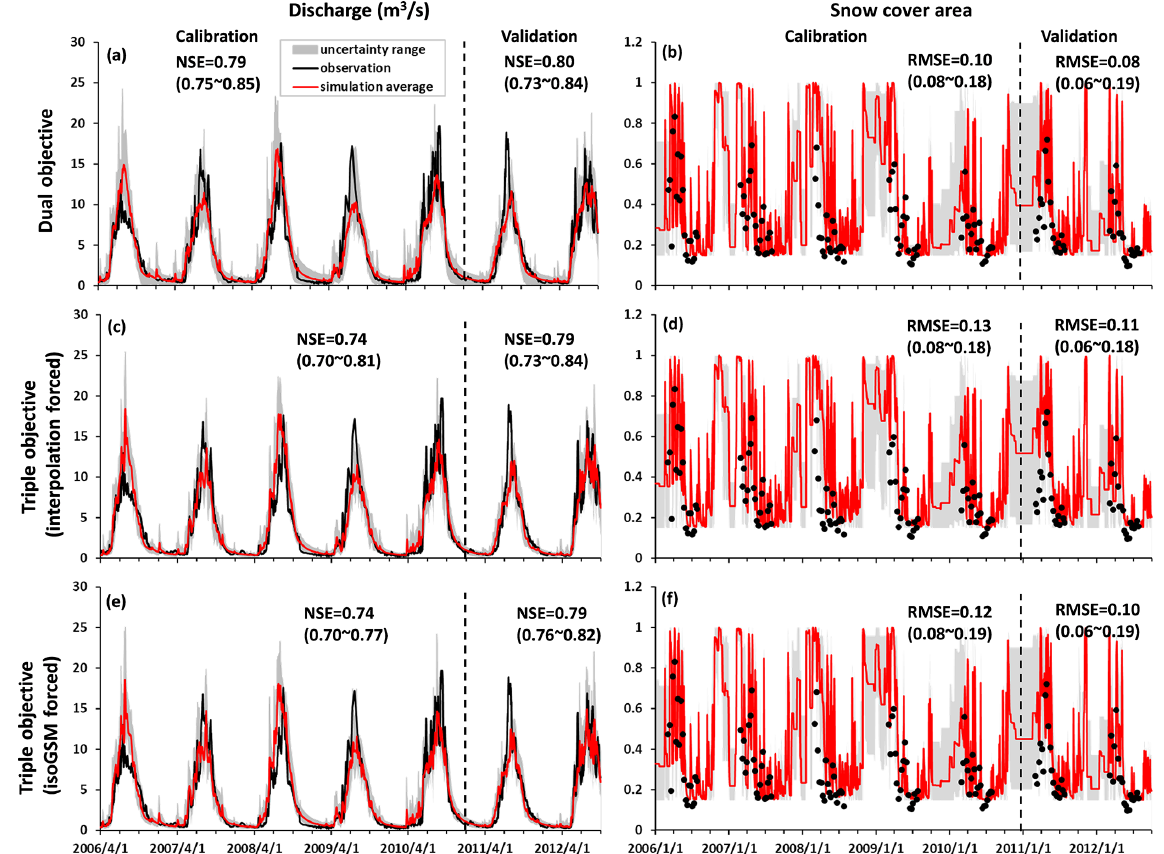
Figure 9. Uncertainty ranges of discharge and SCA simulations in the KR catchment during the calibration and validation periods produced by the behavioral parameter sets of the dual-objective (a, b) , interpolation-forced triple-objective (c, d) and isoGSM-forced triple-objective (e, f) calibration